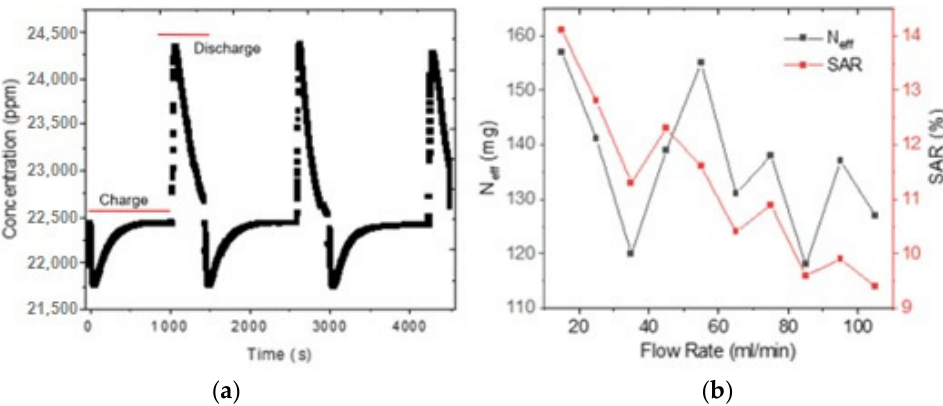
Figure 6. ( a ) Deionization cycles (charge–discharge) of CDI cell (NaCl 0.2 M, 1.2 V, 80 mL/min). ( b ) N eff and SAR variation as a function of flow rate. ( b ) N eff and SAR variation as a function of flow